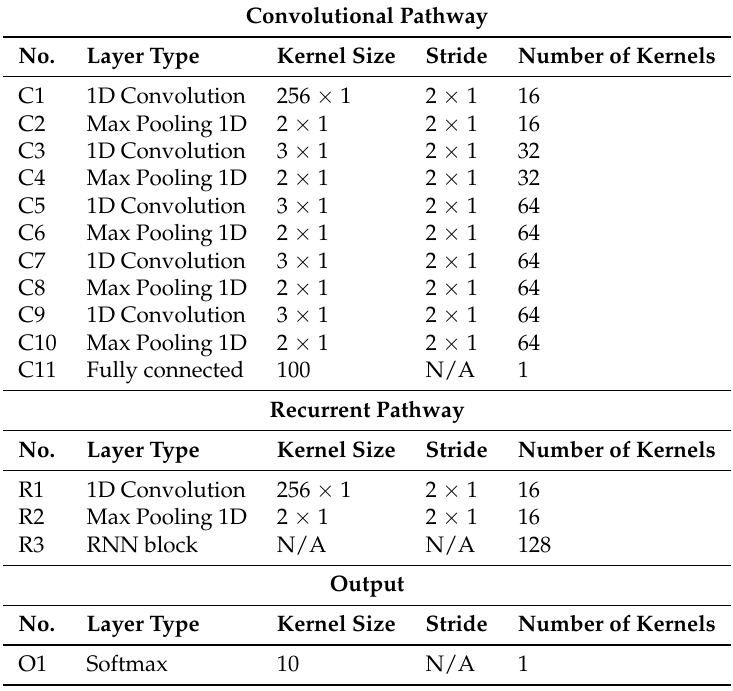
Table 1. Details of the proposed RNN-WDCNN model